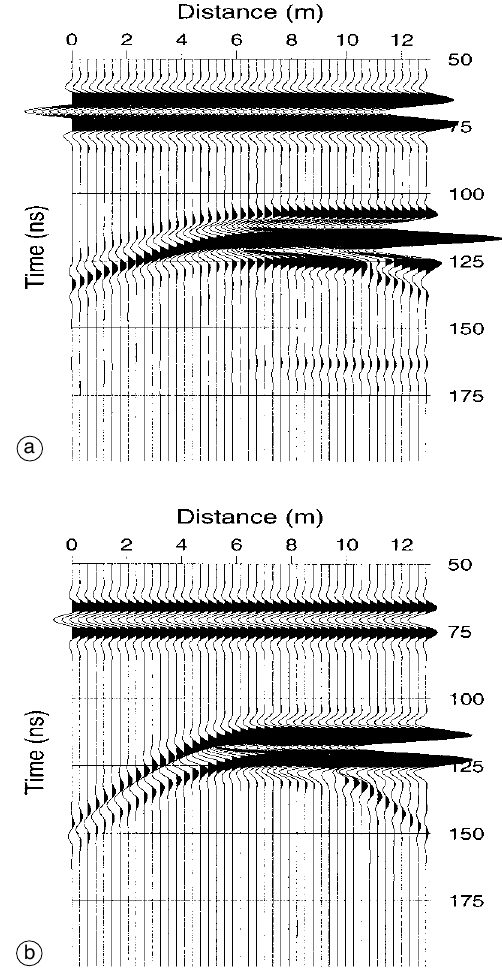
Fig. 2a,b. Synthetic radargrams of magnetic field component, computed with the plane-wave method (a) and the exploding-reflector method (b) (Carcione et al. ,